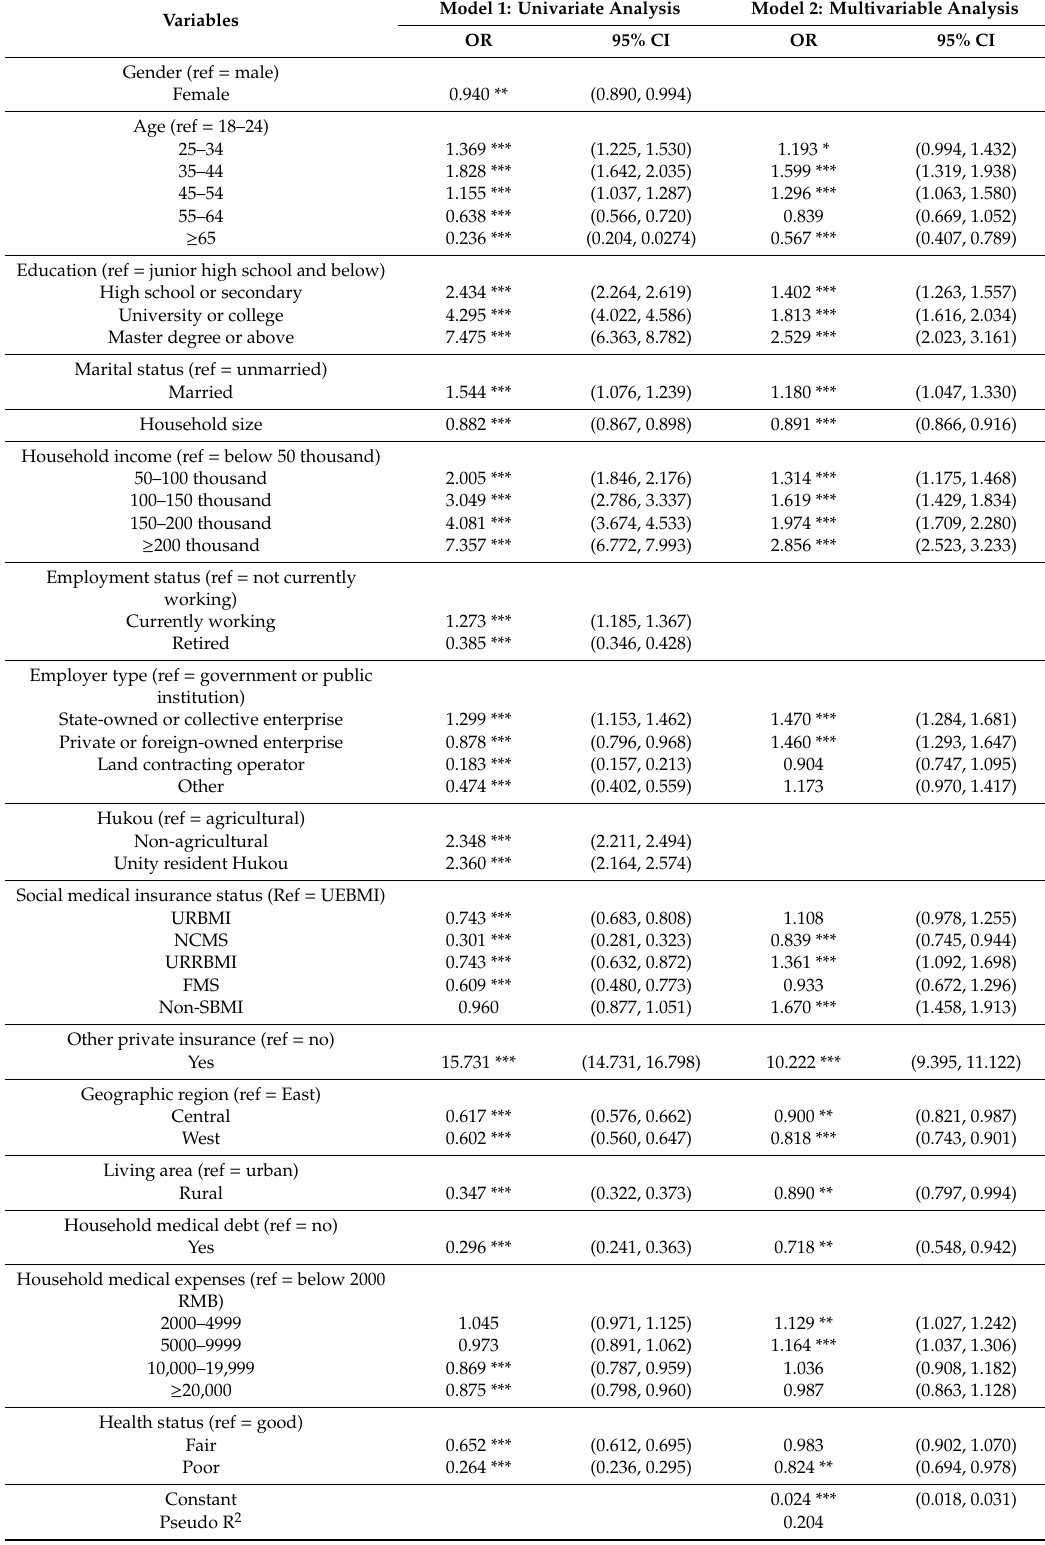
Table 4. Binary logistic regression analysis of predictors of PHI